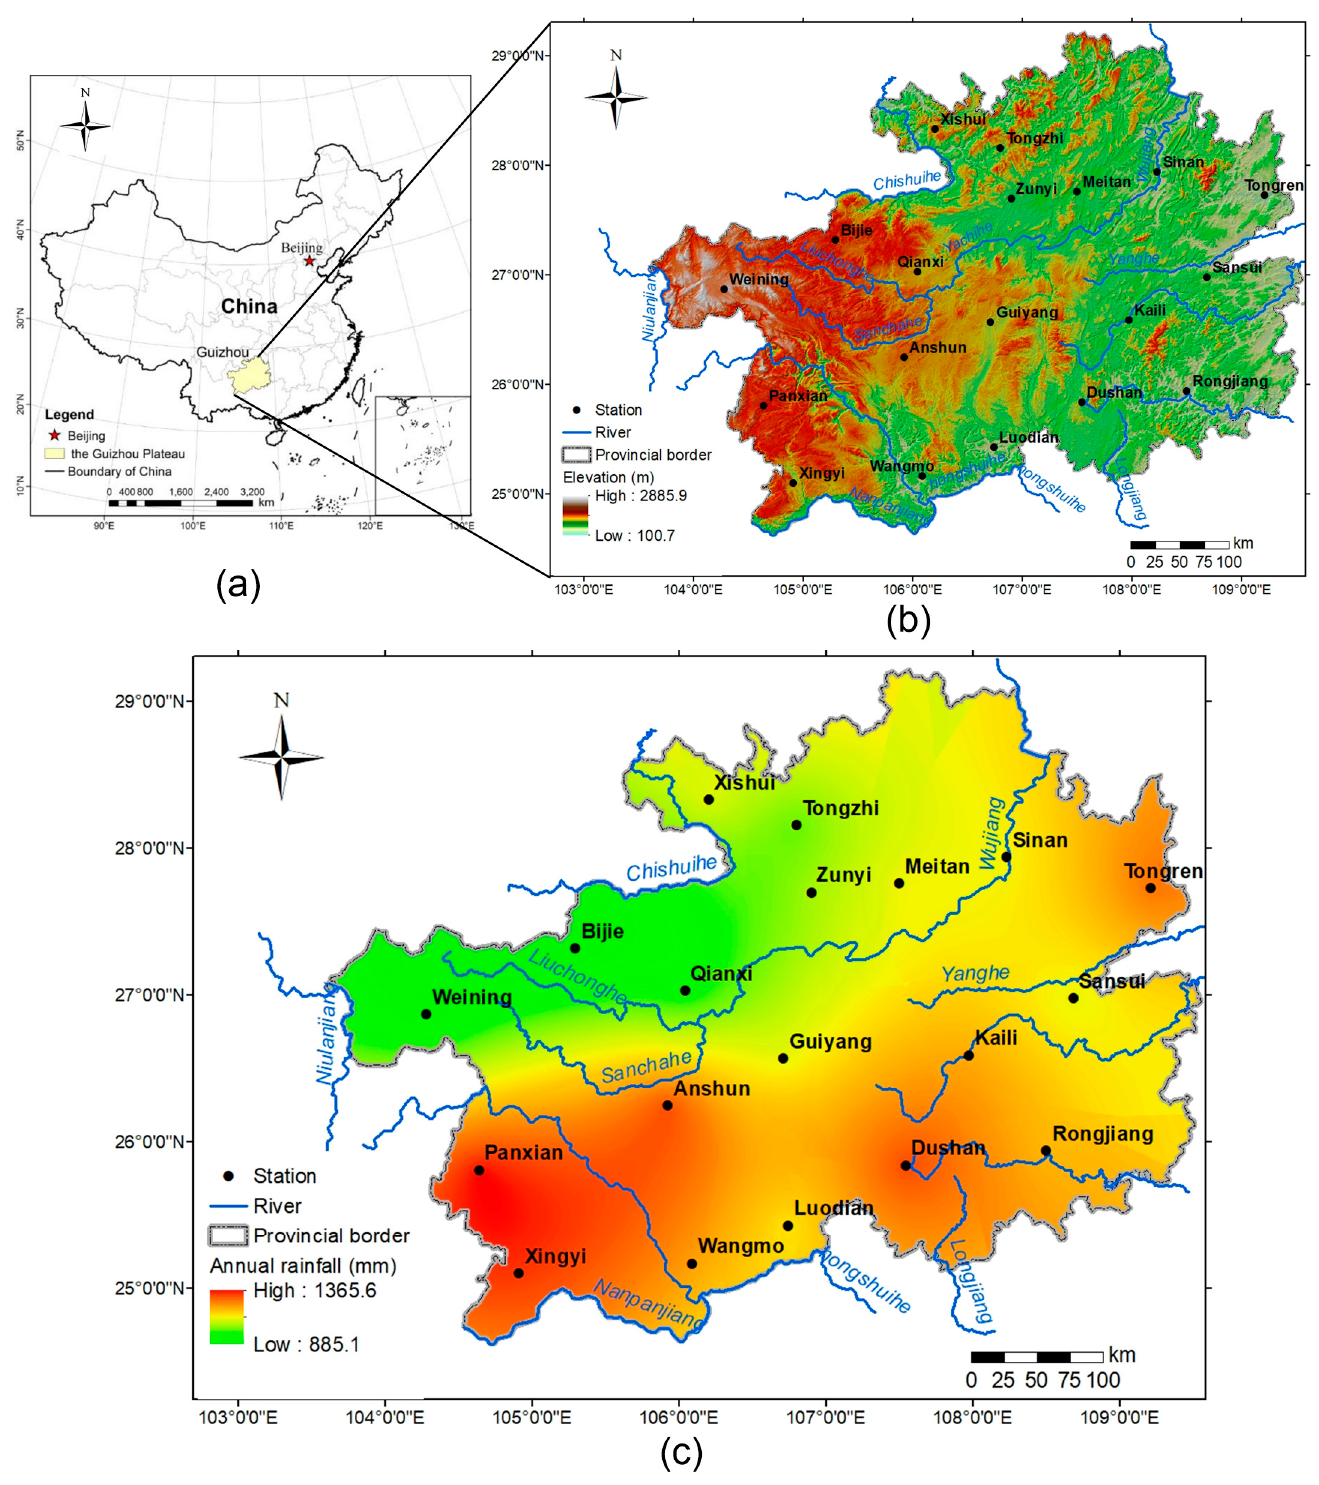
Figure 1. ( a ) The location of study area, ( b ) the topography, and ( c ) the distribution of annual rainfall in Guizhou.